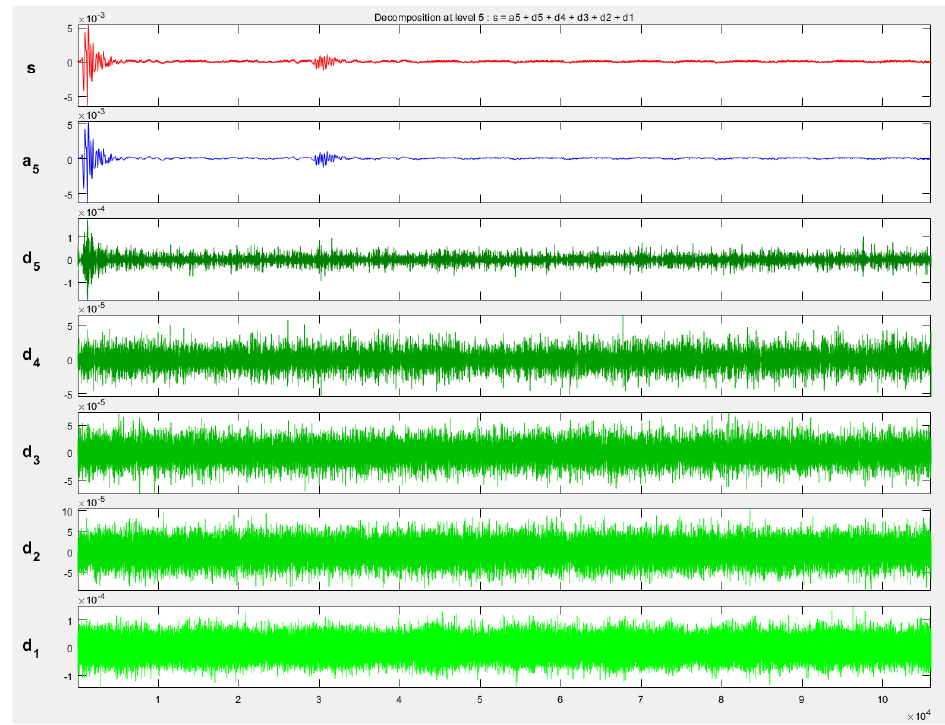
Figure 29. Waveform decomposition diagram of noise S2.